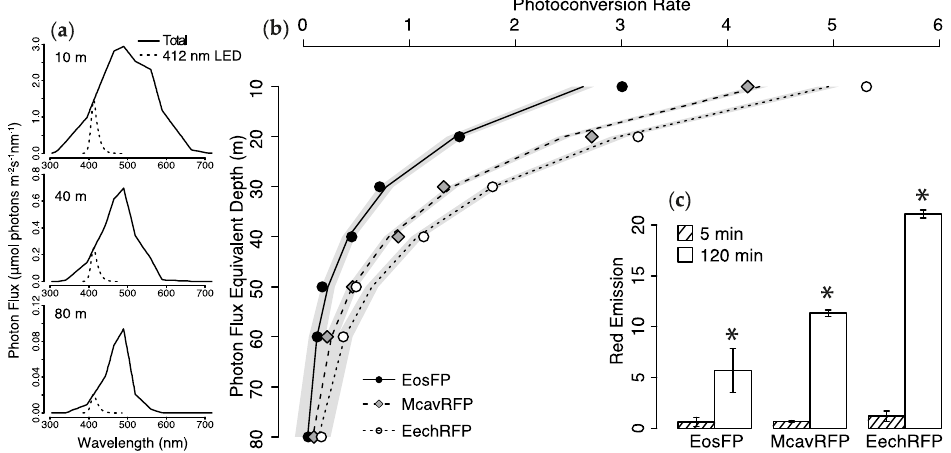
Figure 4. Photoconversion of purified McavRFP, EosFP and EechRFP along a simulated depth gradient. ( a ) Scaling of 412 nm LED to photon flux measurements at 10, 40 and 80 m in the Red Sea [33]; values for total photon flux and scaled 412 nm photon flux are provided in Table S1a; ( b ) Photoconversion rates of pcRFPs along 412 nm photon flux gradient. Points represent the slope of the linear regression equation obtained measuring red fluorescence emission (580–581 nm, ex = 530 nm) during photoconversion every 1 min for 2 h ( n = 3 conversions per protein per photon flux). Lines every 1 min for 2 h ( n = 3 conversions per protein per photon flux). Lines represent fitted represent fitted exponential decay function ±95% c.i. Details and results of statistical analysis are provided in Table S1b; ( c ) Red fluorescence emission (580–581 nm, ex = 530 nm) of purified pcRFPs after 2 h exposure to 0.5 μ mol photons·m − 2 ·s − 1 from 412 nm LED, comparable to the photon flux in the